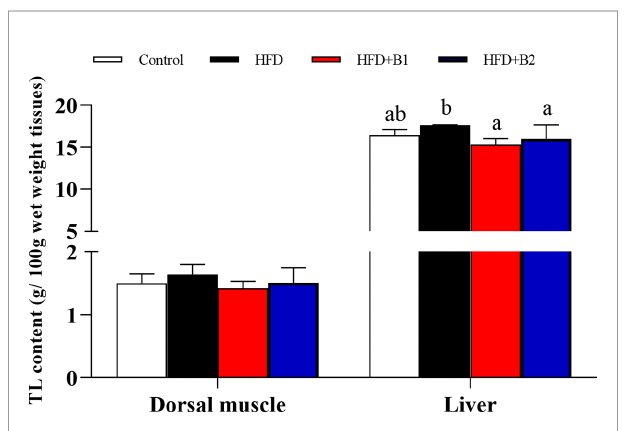
FIGURE 2 | Dorsal muscle and liver lipid contents of juvenile black seabream ( Acanthopagrus schlegelii ) (g/100g wet weight tissues) fed the experimental diets (Control: 11% crude lipid; HFD: high-fat diet; HFD+B1: HFD +betaine (10g/kg); HFD+B2: HFD + betaine (20 g/kg)) for 8 weeks. TL:total lipid. Values are means (n=3), with standard errors represented by vertical bars. Mean values for the same column with different letters were signi fi cantly different ( P < 0.05).